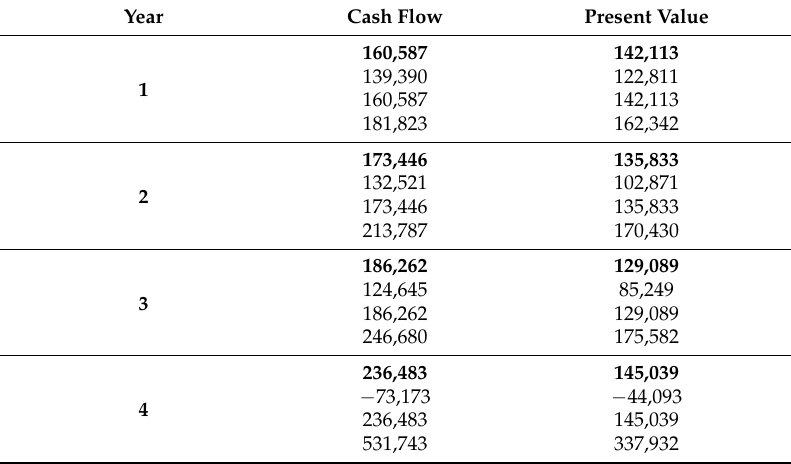
Table 13. Calculation of After Tax Net Present